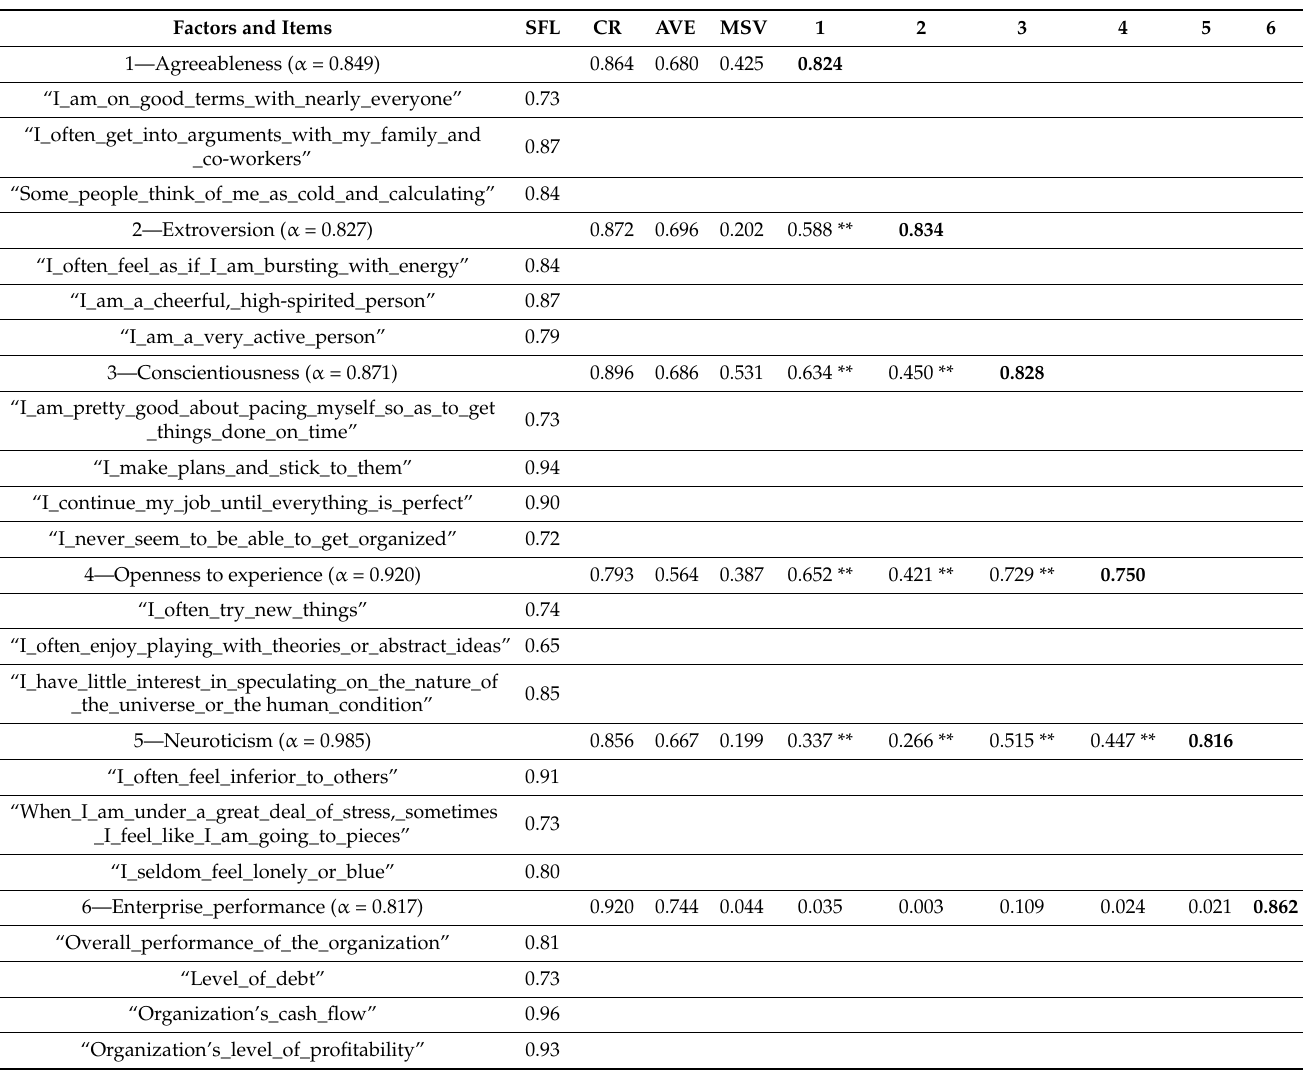
Table 2. The constructs’